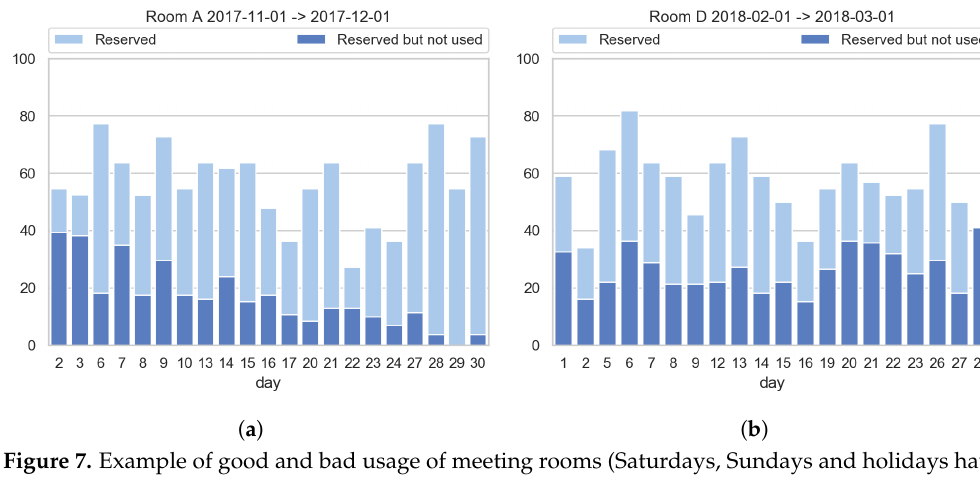
Figure 7. Example of good and bad usage of meeting rooms (Saturdays, Sundays and holidays have been removed): ( a ) shows a correct usage of the booking system, especially in the second half of the month. ( b ) on the contrary shows a worse usage of the booking system as a big part of the time the room is reserved but not used.